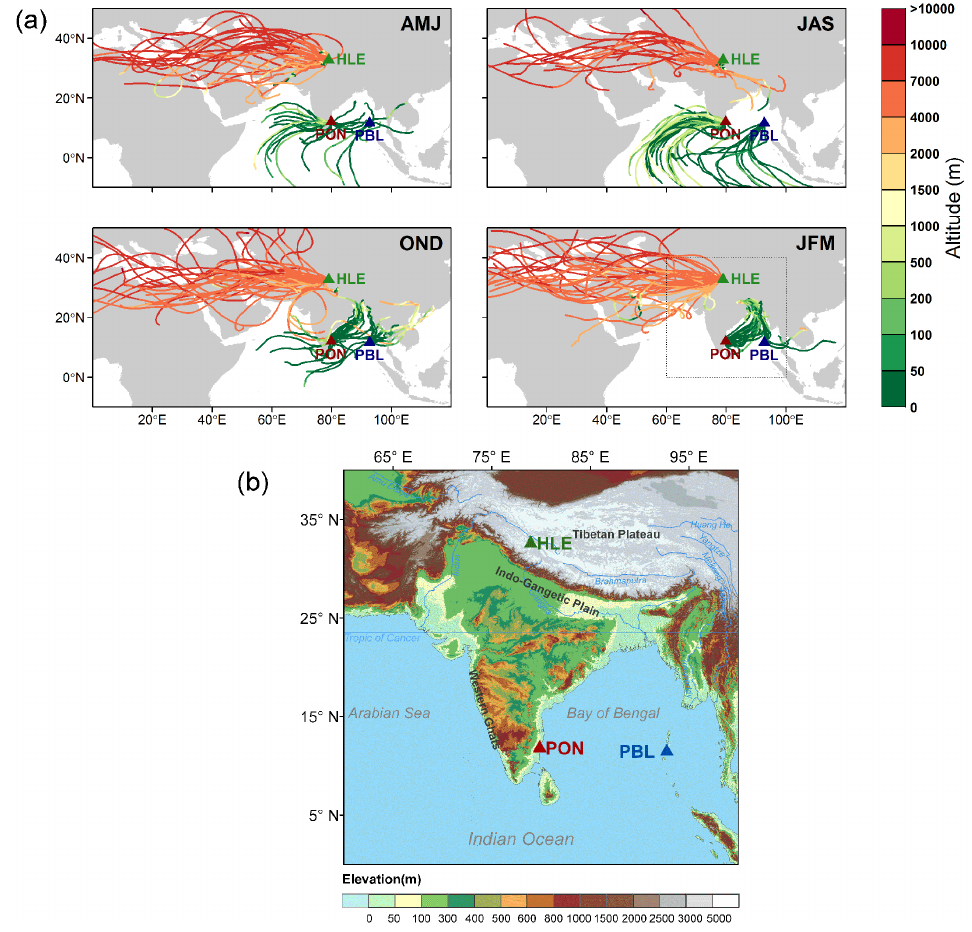
Figure 1. (a) Five-day back trajectories calculated for all sampling dates over the period 2007–2011 at Hanle (HLE), Pondicherry (PON), and Port Blair (PBL) during April–June (AMJ), July–September (JAS), October–December (OND) and January–March (JFM). Back trajectories are colored by the elevation of air masses at hourly time step. (b) Close-up terrain map from the box in (a) , showing locations of HLE, PON and PBL. The digital elevation data are obtained from NASA Shuttle Radar Topographic Mission (SRTM) product at 1km resolution